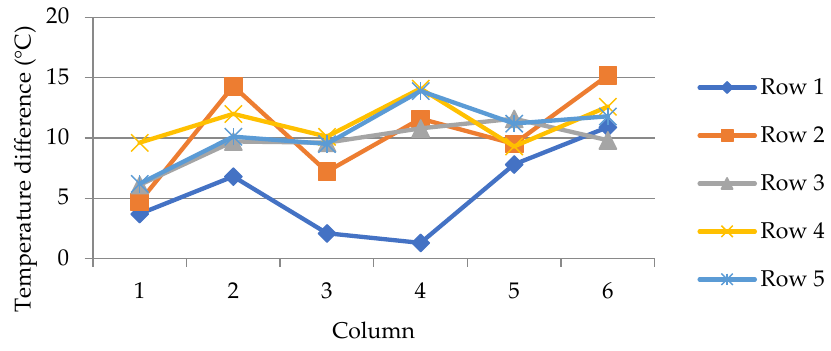
Figure 19. Change in cell temperature of the first five rows of module.